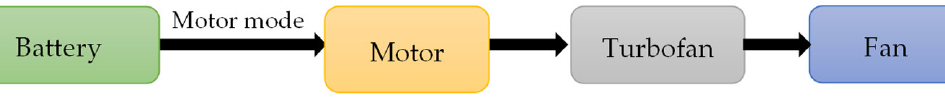
Figure 4. Parallel hybrid [32].